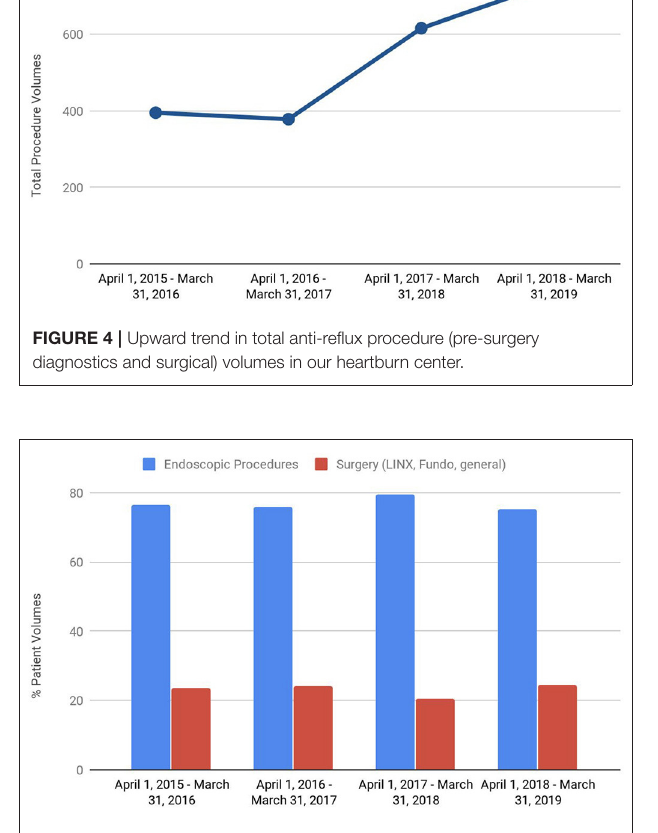
FIGURE 5 | Patient volumes as a percentage of the total pre-surgery diagnostics and surgical volumes.